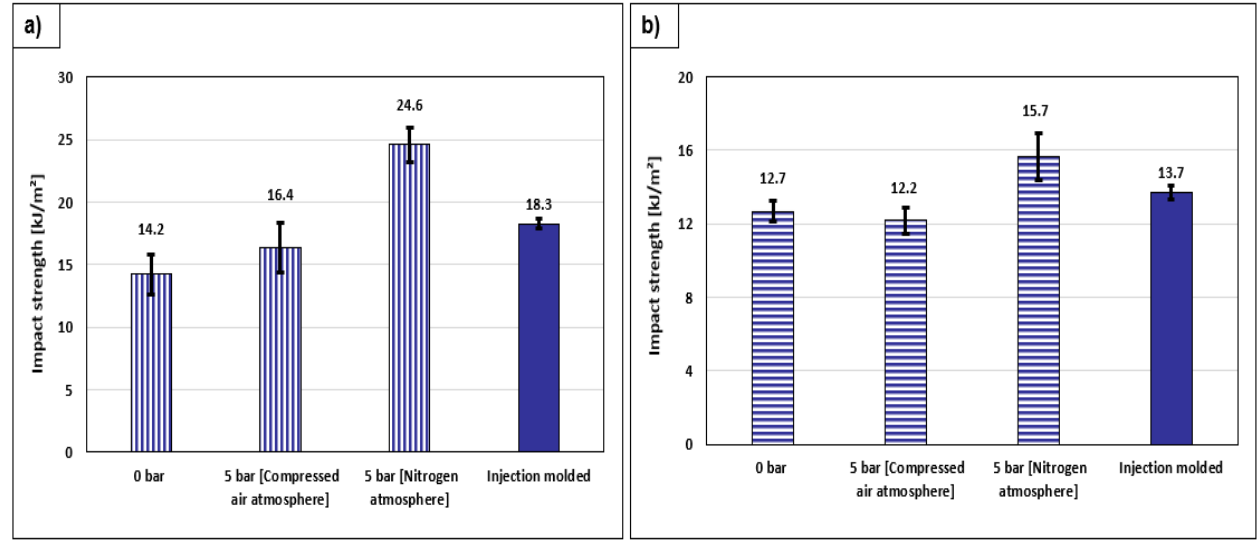
Figure 8. Comparison of the impact strength of samples printed under various pressure conditions in the longitudinal ( a ) and transverse ( b ) printing directions.